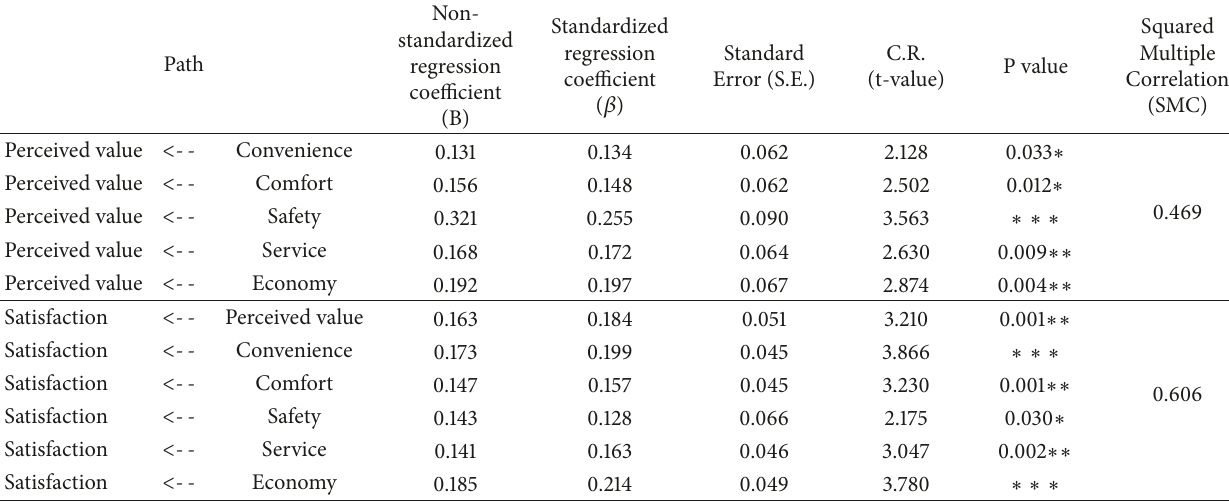
Table 7: Calculation results of the structural model.